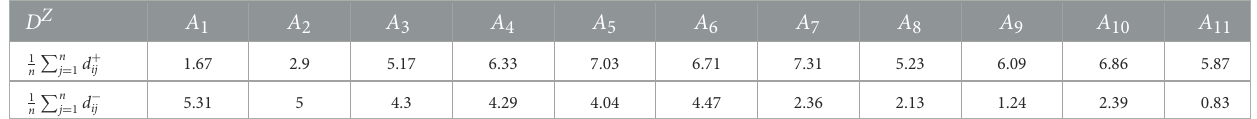
TABLE 2 Reference points of